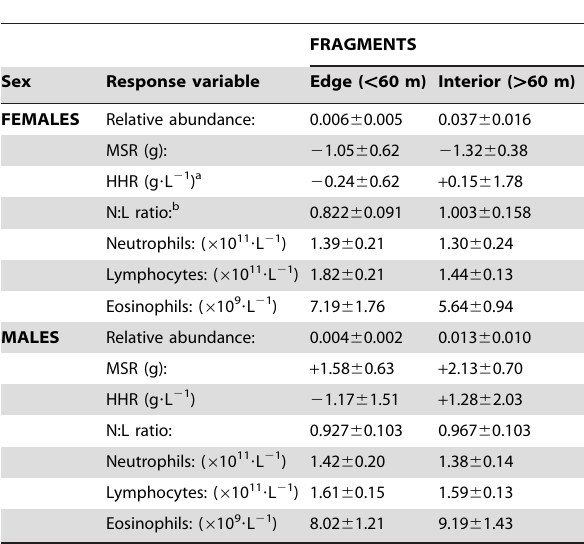
Table 1. Summary of mean ( 6 s.e.) values obtained for stress and condition indicators in this study.